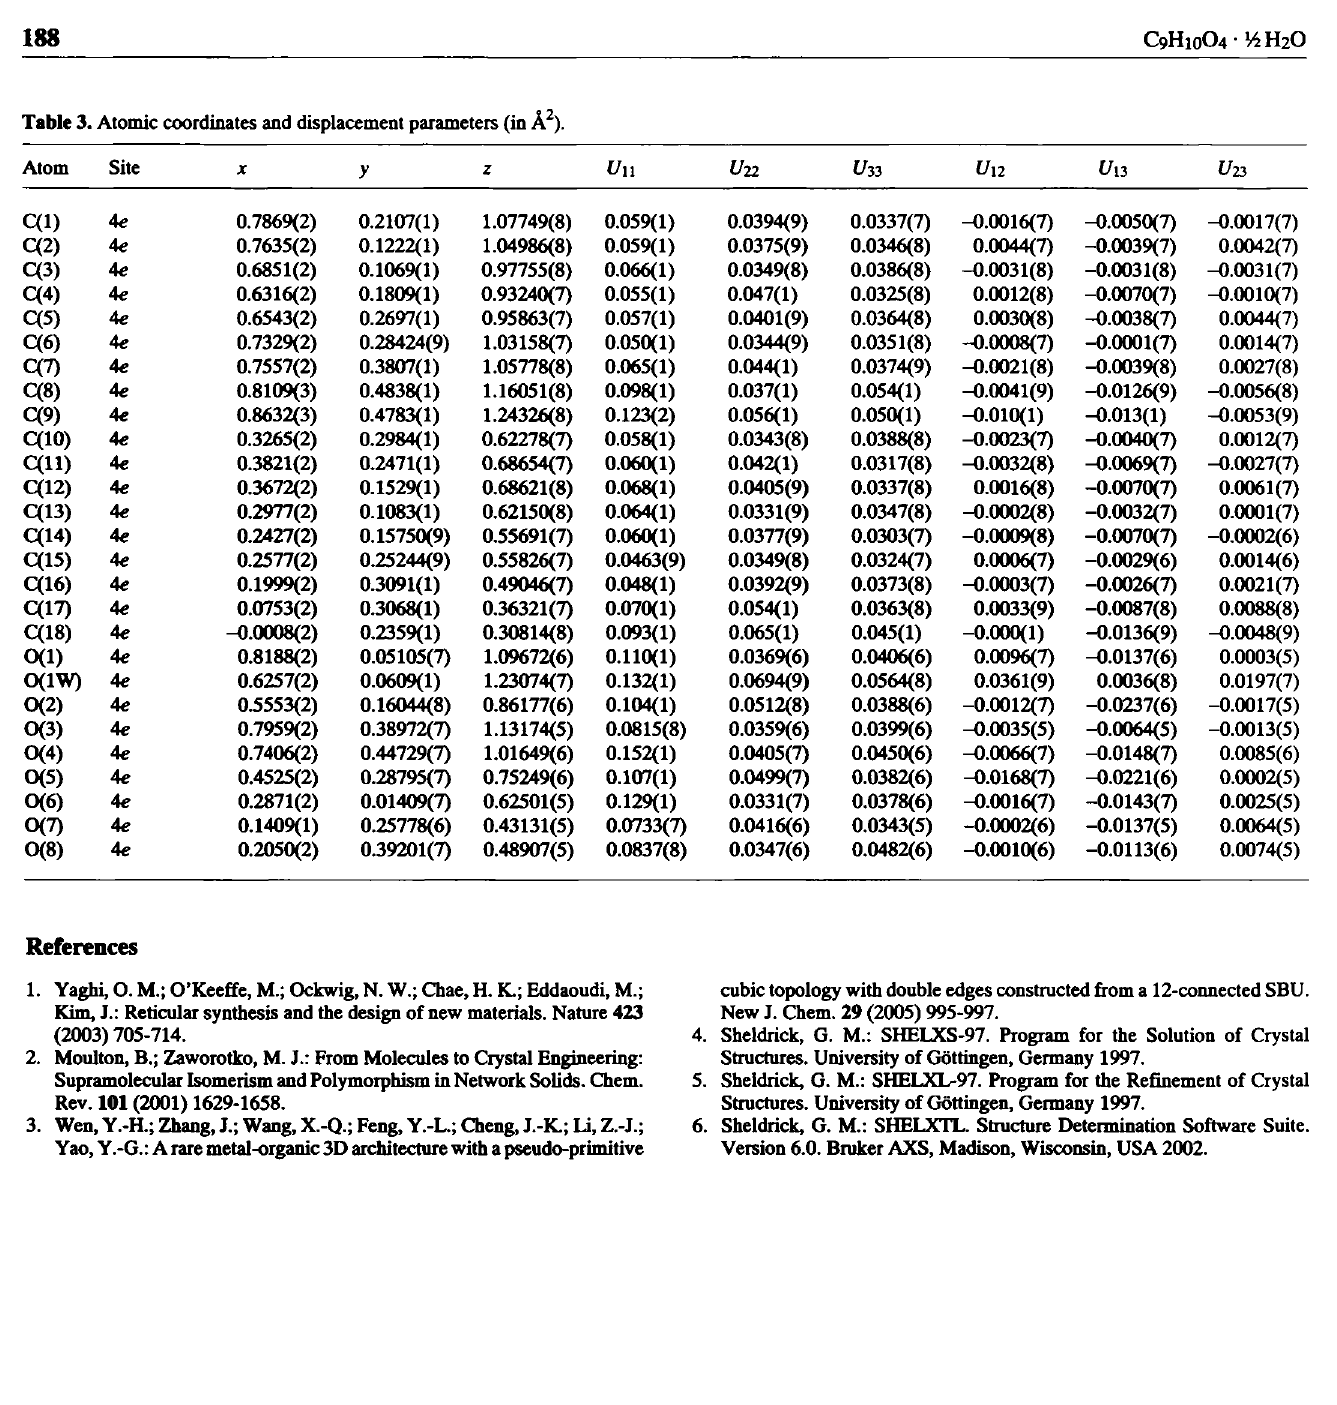
Table 3. Atomic coordinates and displacement parameters (in Ä 2